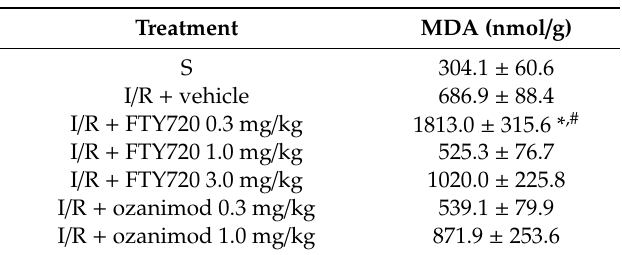
Table 1. E ff ects of S1P modulators on I / R-induced lipoperoxidation. Malondialdehyde (MDA) levels in small intestinal tissues excised from S mice and from I / R mice administered with vehicle, FTY720 (0.3–3.0 mg / kg i.v.) or ozanimod (0.3, 1.0 mg / kg s.c.) ( n = 6–10 animals per group). Data are expressed as the mean value ± s.e.m.